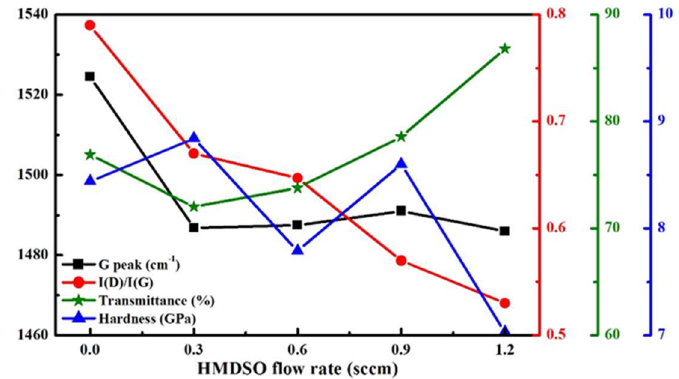
Figure 6. The analysis of DLC properties and transmittance at the different HMDSO flow rates. (RF bias = 400 V, DC power = 50 W, CH 4 = 12.5 sccm, thickness = 65 ± 5 nm)